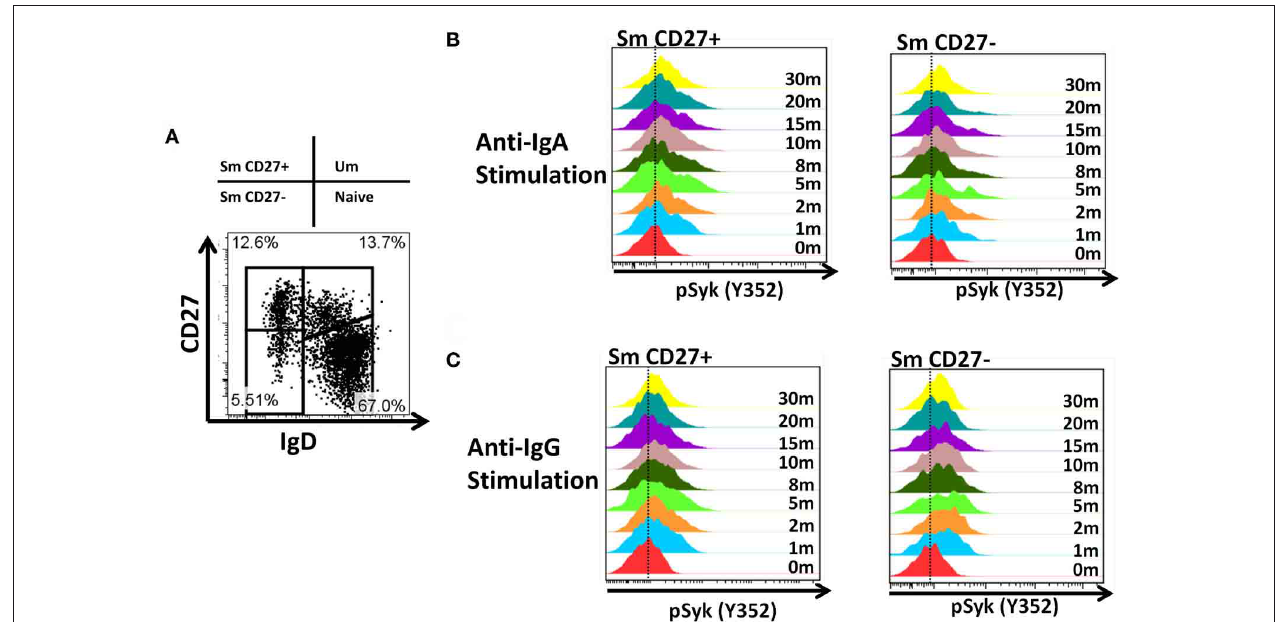
FIGURE A2 | Time course of phosphorylation of pSyk in Sm CD27 + and Sm CD27 − B cells following anti-IgA and anti-IgG stimulation. PBMC from healthy volunteers were stimulated with either anti-IgA or anti-IgG and phosphorylation of Syk was evaluated at different time